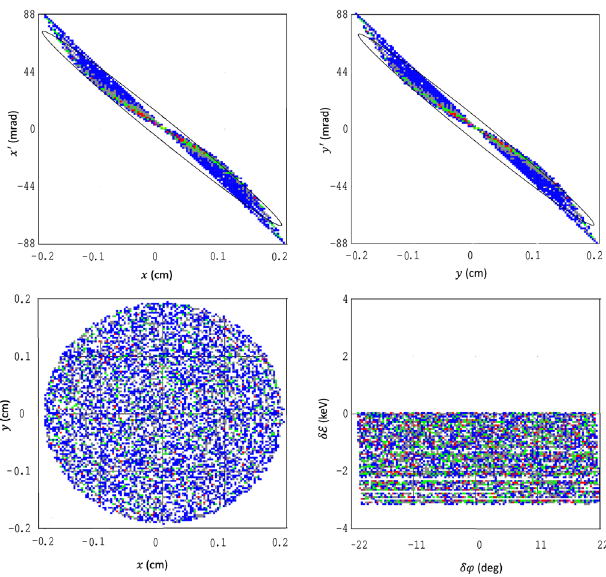
FIG. 21. Beam phase-space in the exit plane of the input aperture. The cathode is flat ; the emittance is 1.9 mm